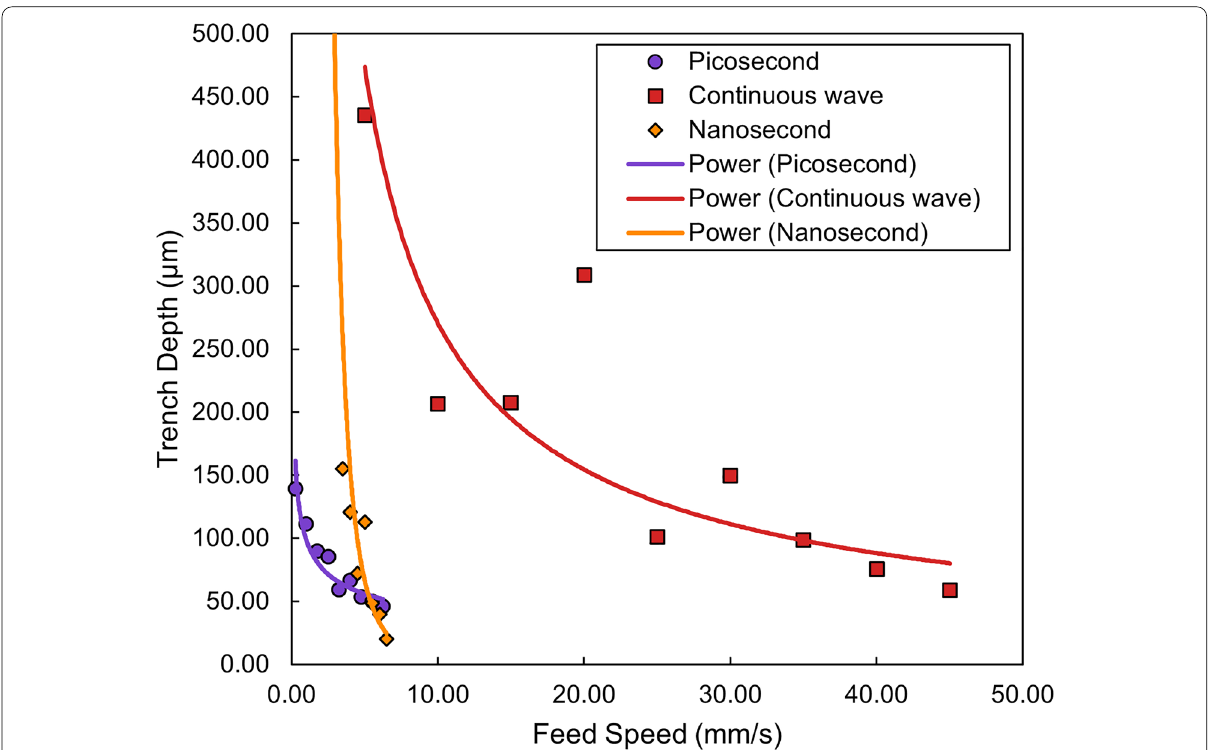
Figure 6 Investigation into the effect of feed speed on the trench depth: the maximum trench depth taken from the mean cross‑sectional profiles were plotted over a range of feed speeds to compare the efficiency and predictability of machining by the different laser types